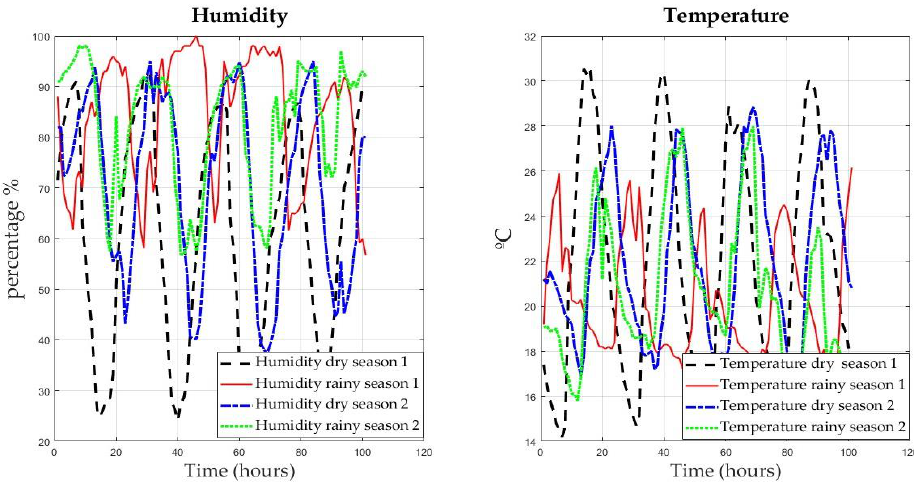
Figure 7. Dynamics of humidity and temperature during the climatic seasons.